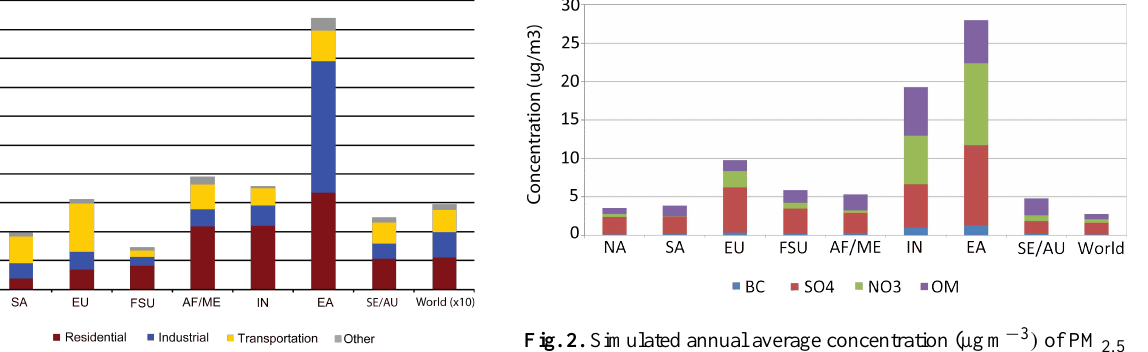
Fig. 2. Simulated annual average concentration (µgm − 3 ) of PM 2 . 5 components for the base case (2002) by geographic